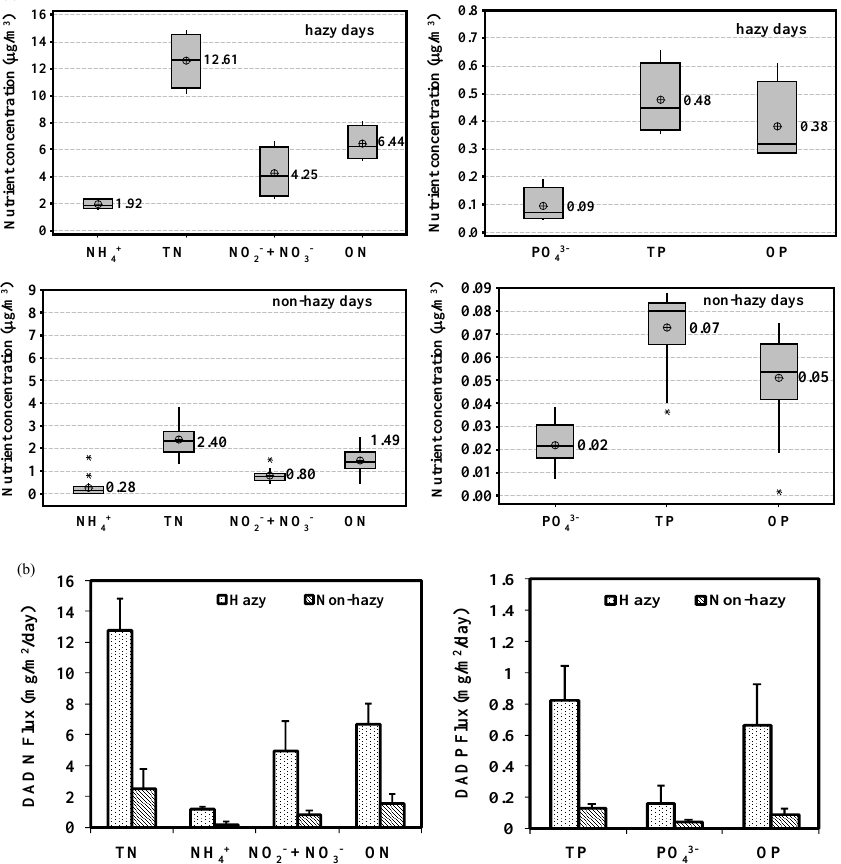
Fig. 5. (a) Box plot showing mean concentration of nutrients (N and P species) (µg/m 3 ) in aerosol samples on selected days with hazy (October 2006) and non-hazy (November 2006 – January 2007) conditions (crossed circle shows mean); (b) Fluxes of nutrients (N and P species) in DAD during hazy and non-hazy days. Note: In Figure 5a, the bottom and the top edges of each box are located at the sample 25 and 75 percentiles, the height of each box shows the interquartile range for each species which is an indicator of the variability of the values; the central horizontal line is drawn at the sample median.